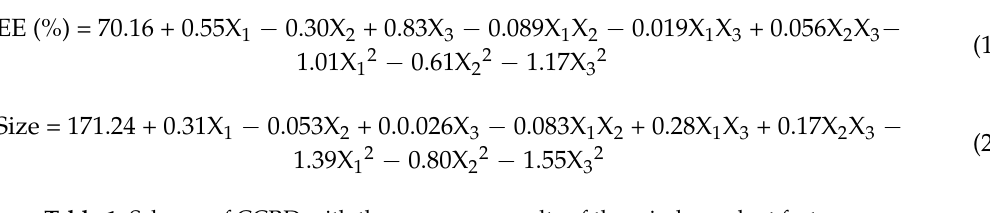
Table 1. Scheme of CCRD with the responses results of three independent